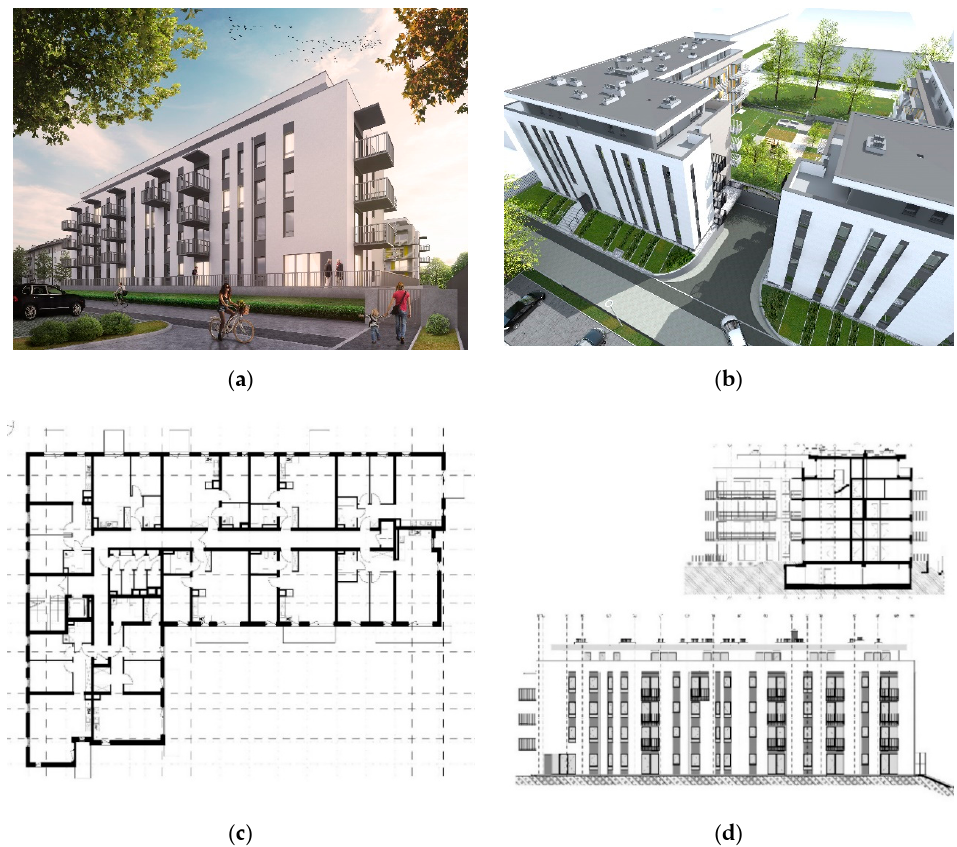
Figure 1. The building at Sadowskiego Street in Szczecin. ( a ) Visualization 01; ( b ) visualization 02; ( c ) floor plan; ( d ) cross section and east elevation.